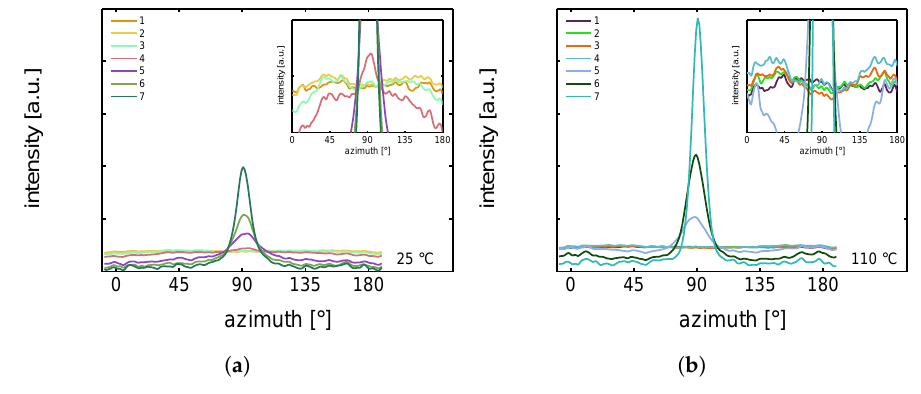
Figure 12. Azimuthal spread of the (110) diffraction of α -iPP at various strains; ( a ) uni-axial stretching at 25 ◦ C and ( b ) 110 ◦ C. The numbers in the legend correspond to the 2D patterns in Figure